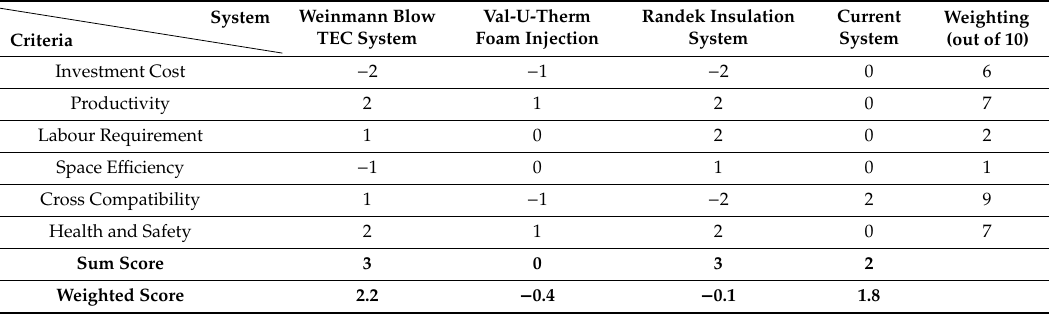
Table 7. Resultant scores for